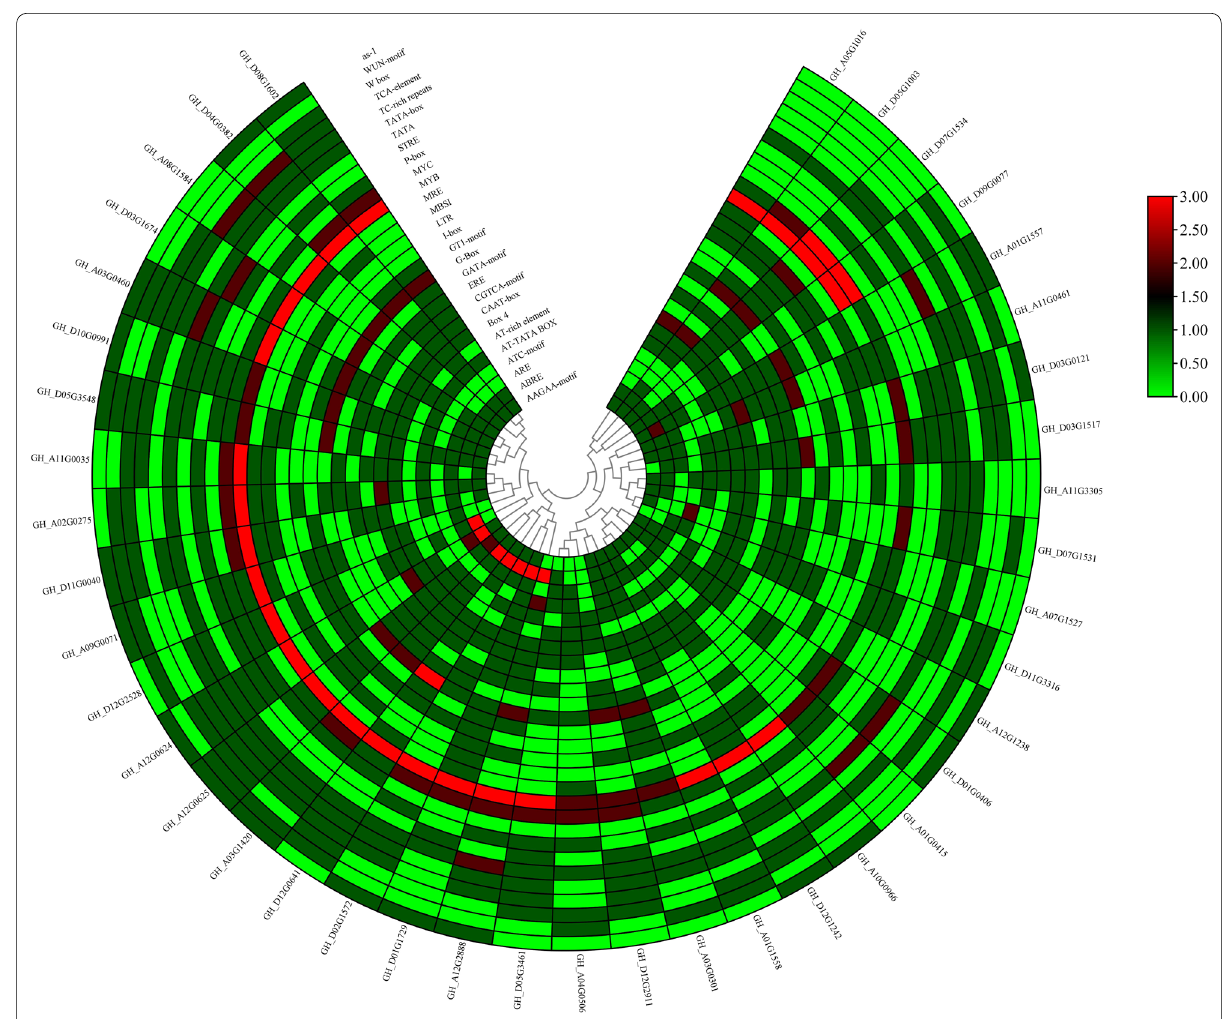
Fig. 6 GHMAPK identified cis -regulatory